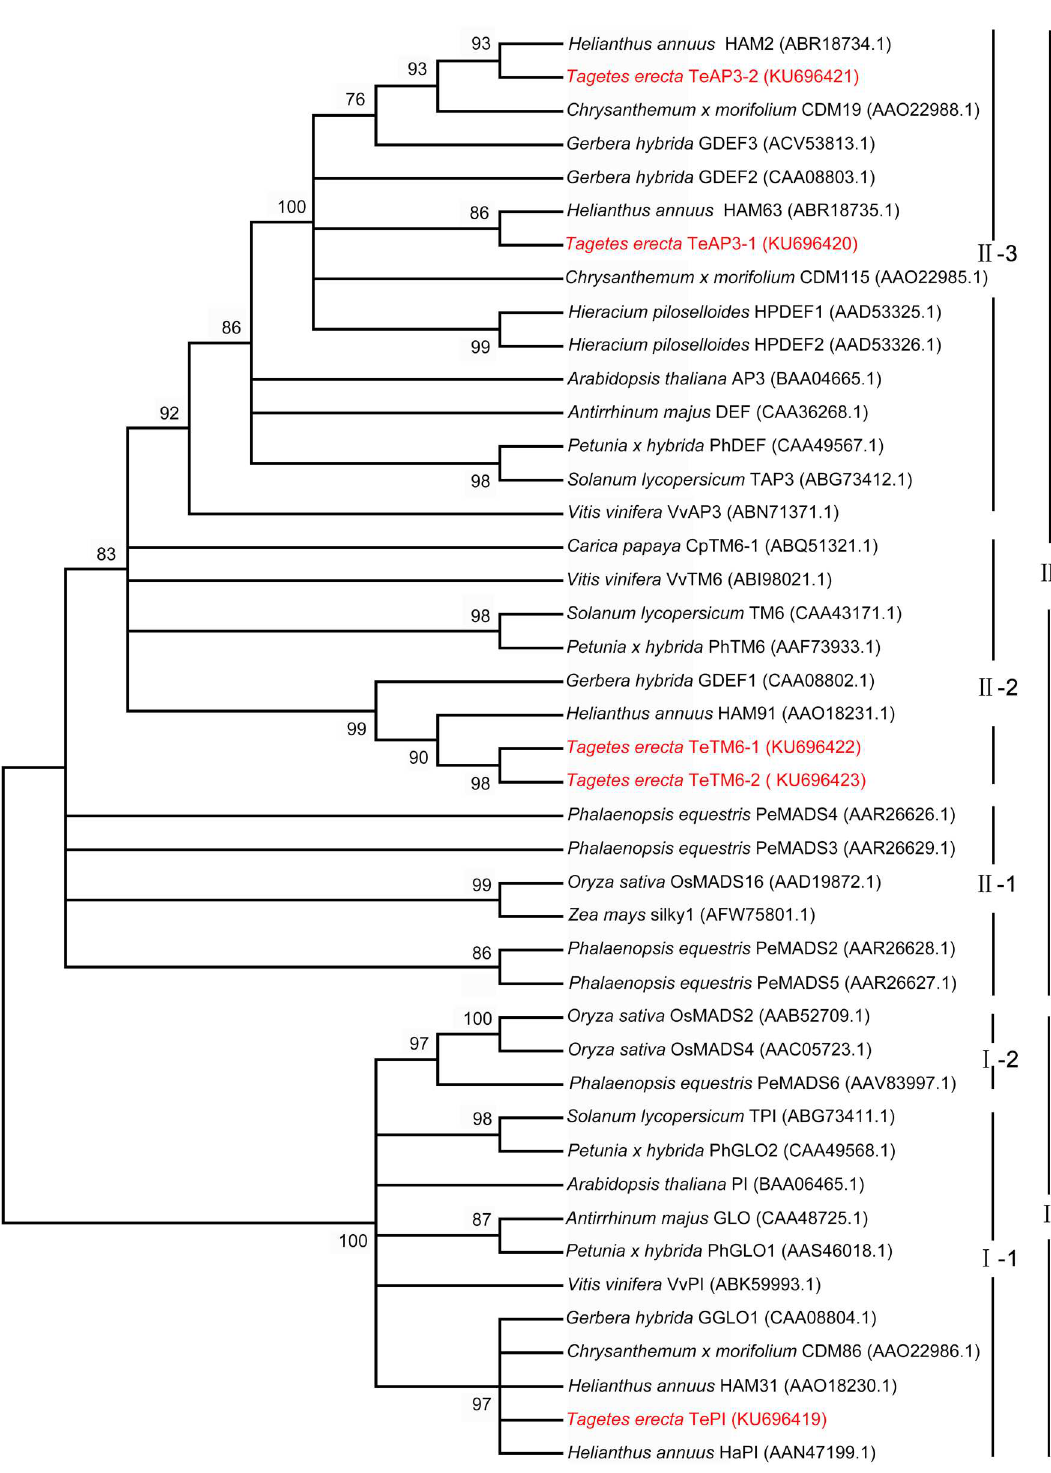
PLOS ONE | DOI:10.1371/journal.pone.0169777 January12,